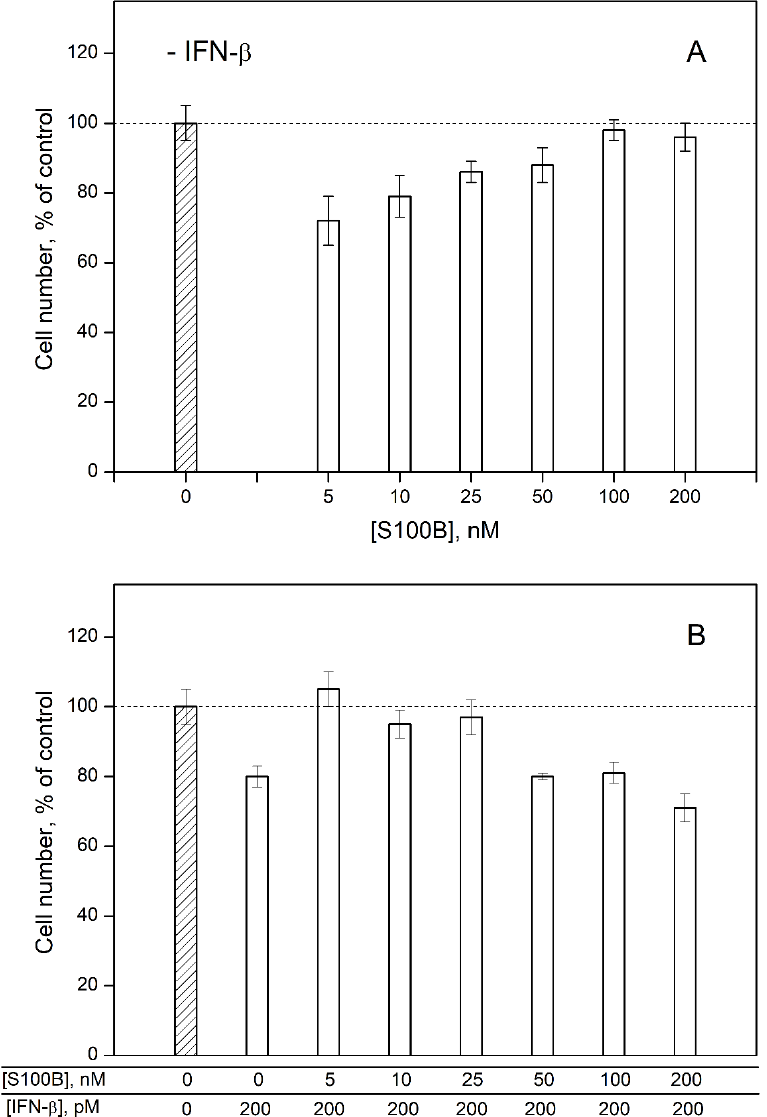
Figure 5. The data of crystal violet assay for viability of MCF-7 cells treated by S100B (panel ( A )), IFN- β or their combination ( B ).